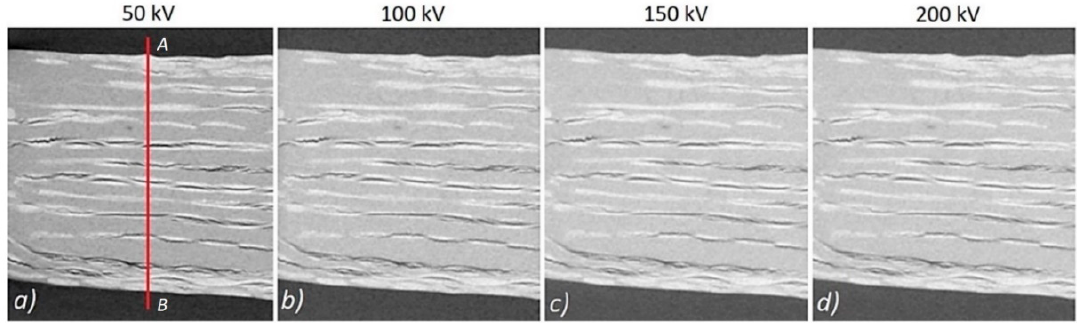
Figure 6. Cross-sections through the PP composite obtained with the X-ray tube voltage: ( a ) 50 kV, ( b ) 100 kV, ( c ) 150 kV, ( d ) 200 kV.